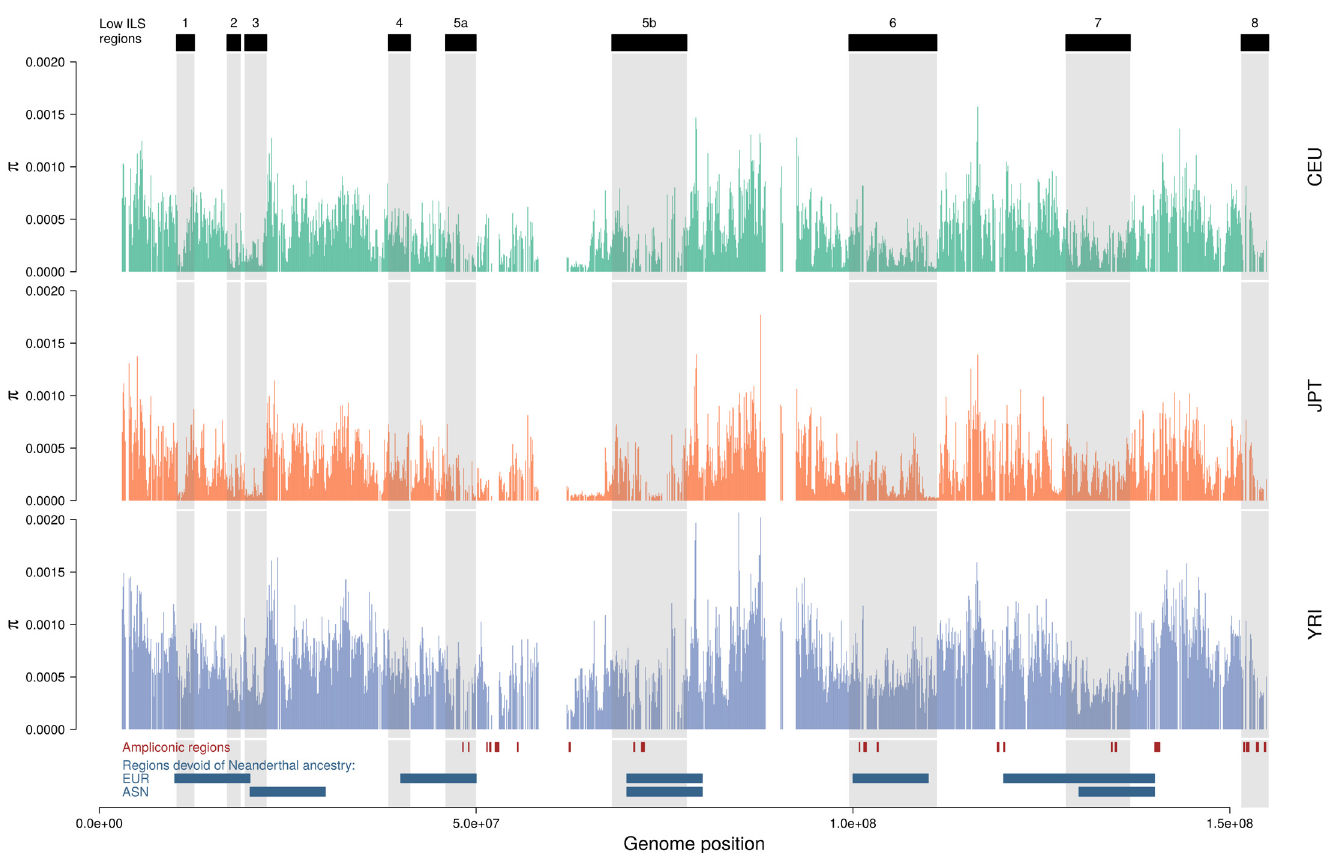
Fig 5. Distribution of nucleotide diversity along the X chromosome of human populations. Nucleotide diversity is computed in 100 kb non-overlapping windows. Ampliconic regions [34] as well as regions with no Neanderthal introgression [14] are shown at the bottom. S5 Fig shows all 14 populations.